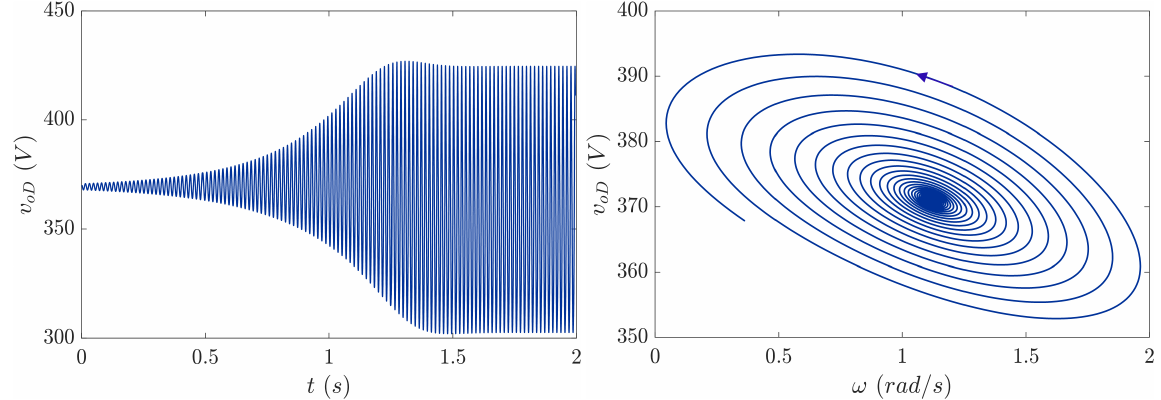
Figure 5. Periodic oscillations due to SHB bifurcation in D q =